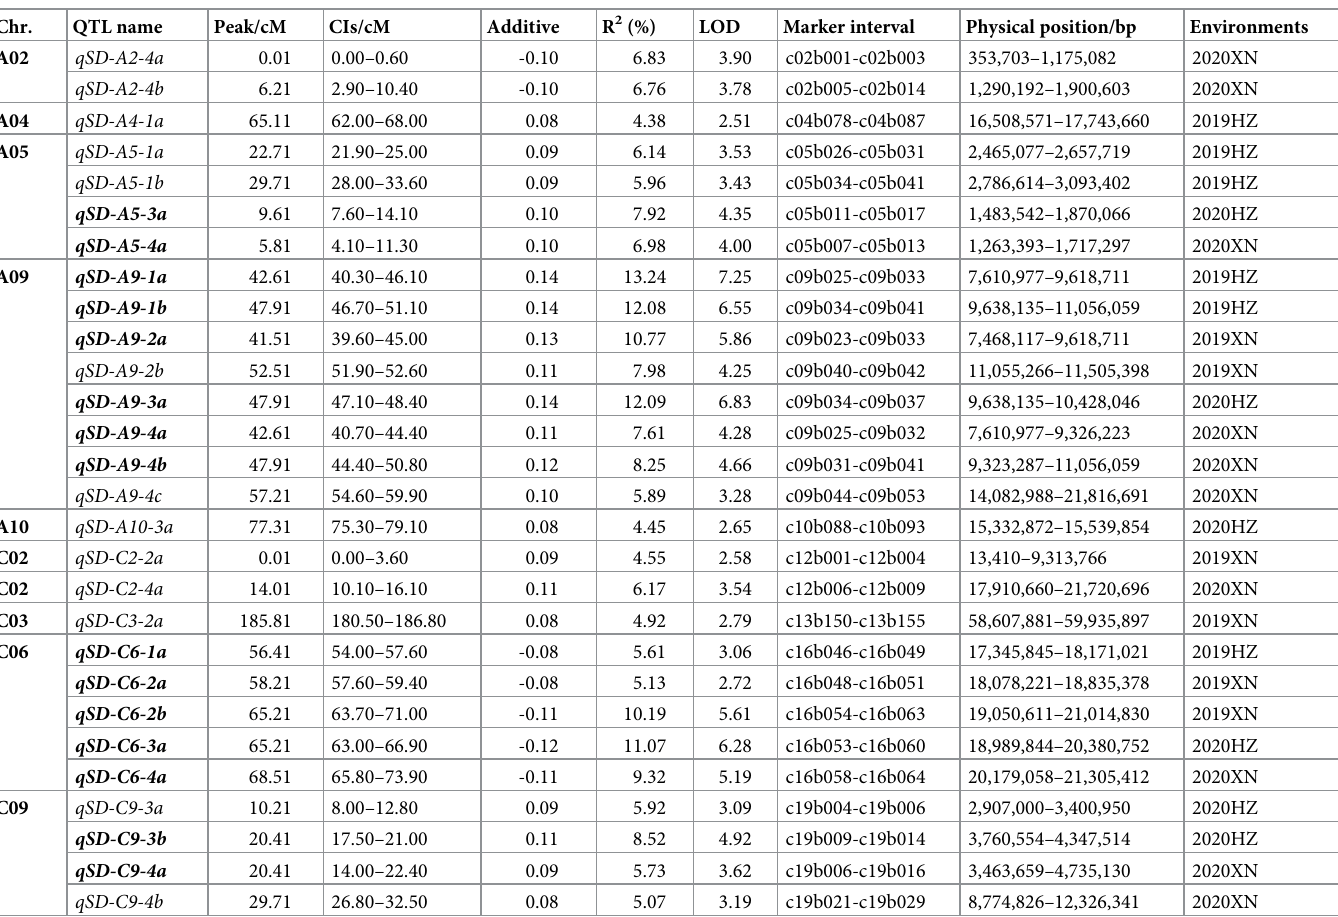
Table 5. QTLs for SD in four environments.